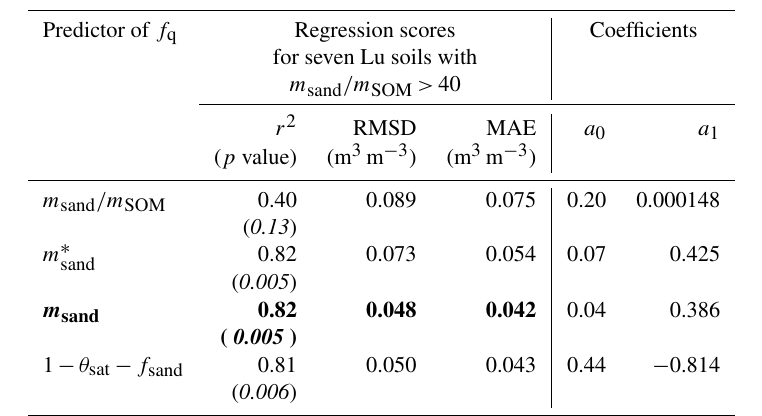
Table 6. Pedotransfer functions of f q (Eq. 12) for seven soils of Lu et al. (2007) with m sand /m SOM > 40. The best predictor and the best scores are in bold. The regression p values are within brackets and in italics.